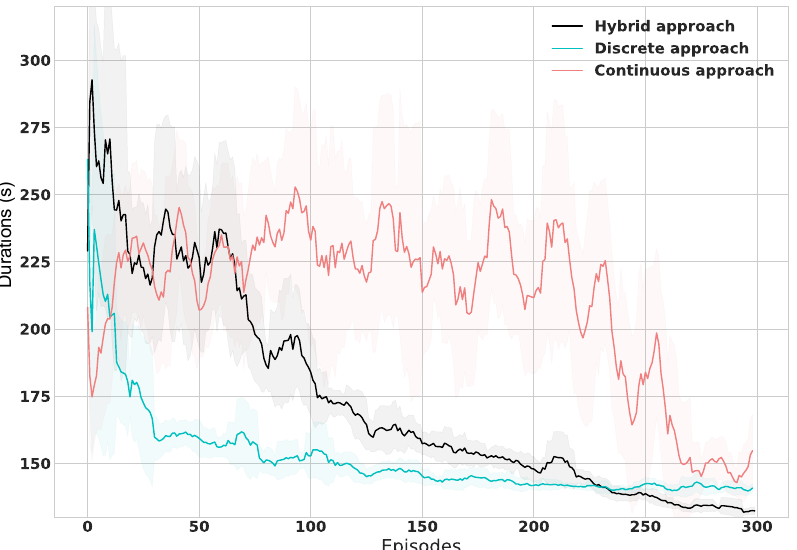
Figure 7. Travel Time Training Curves Comparison of Hybrid Framework Against Discrete and Continuous Benchmarks.